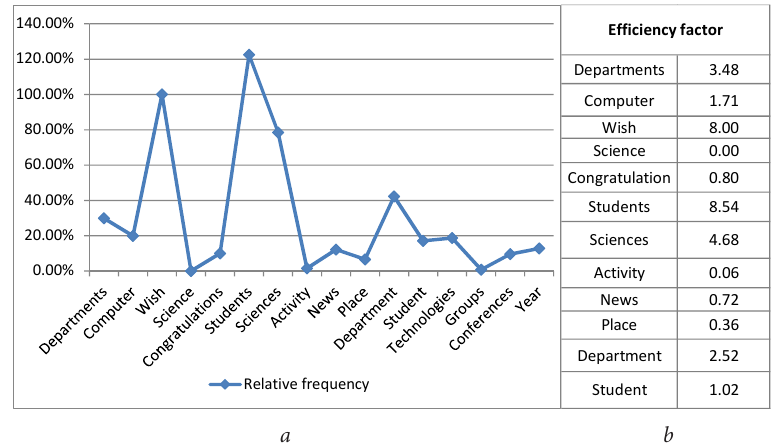
Fig. 4. Keyword efficiency factor: a – relative frequency graph (keyword efficiency, %); b – table values of efficiency